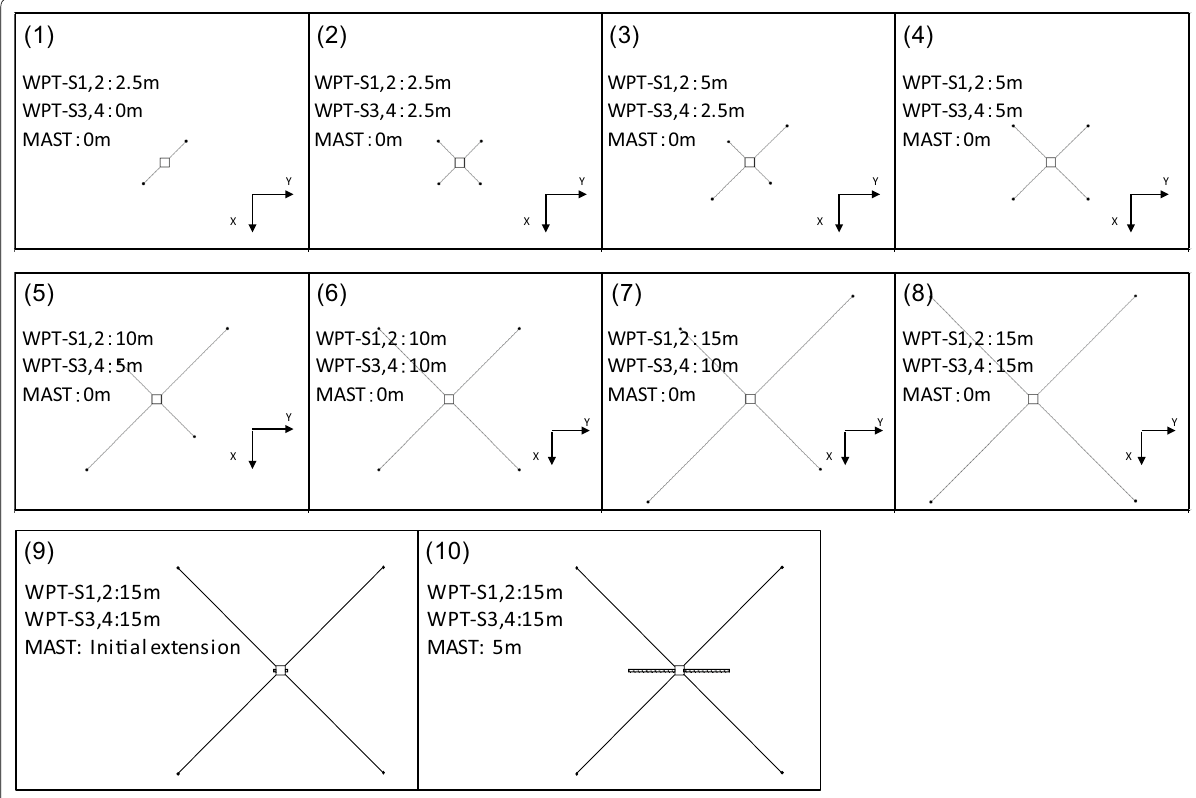
Fig. 15 Deployment sequence for the wire probe antennas and